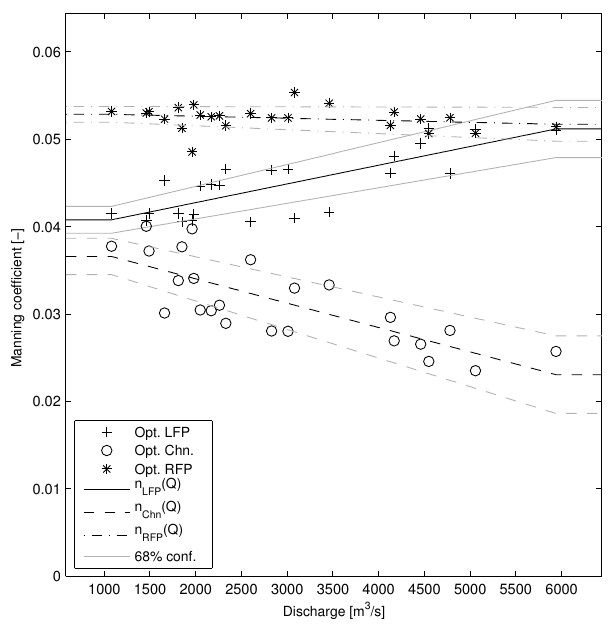
Fig. 3. Parameterisation of Manning roughness coefficients on dis- charge; circles, stars and crosses represent, respectively, channel, right-hand and left-hand floodplain roughness values obtained from the optimisation of the non-parameterised model; lines follow the function given by Eq. (6), fitted to the data; thick dashed lines show the linear fit and dashed thin lines present 0.68 confidence limits for the fit.